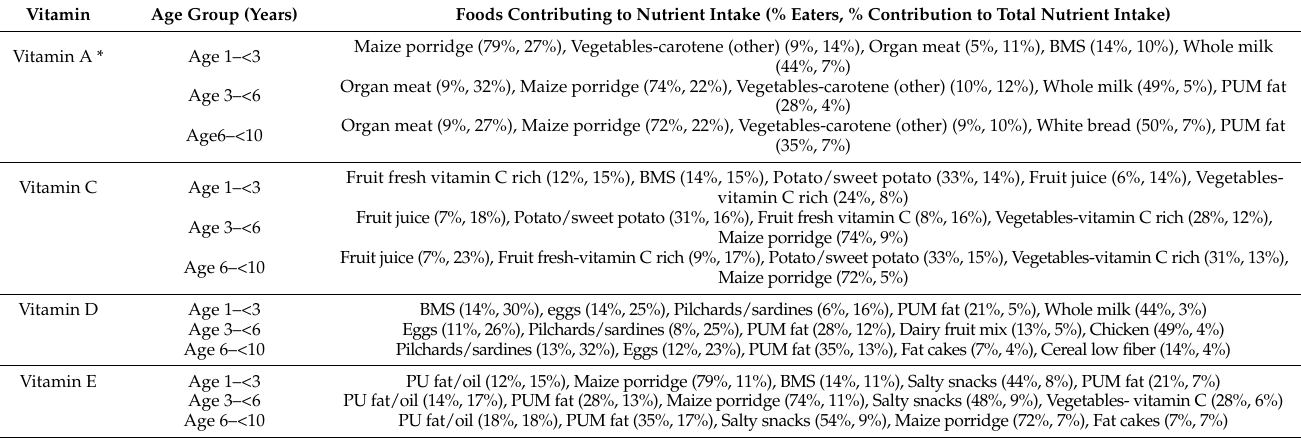
Table 8. Top 5 food items that contributed to vitamins A, C, D and E intakes, by age group (Day-1